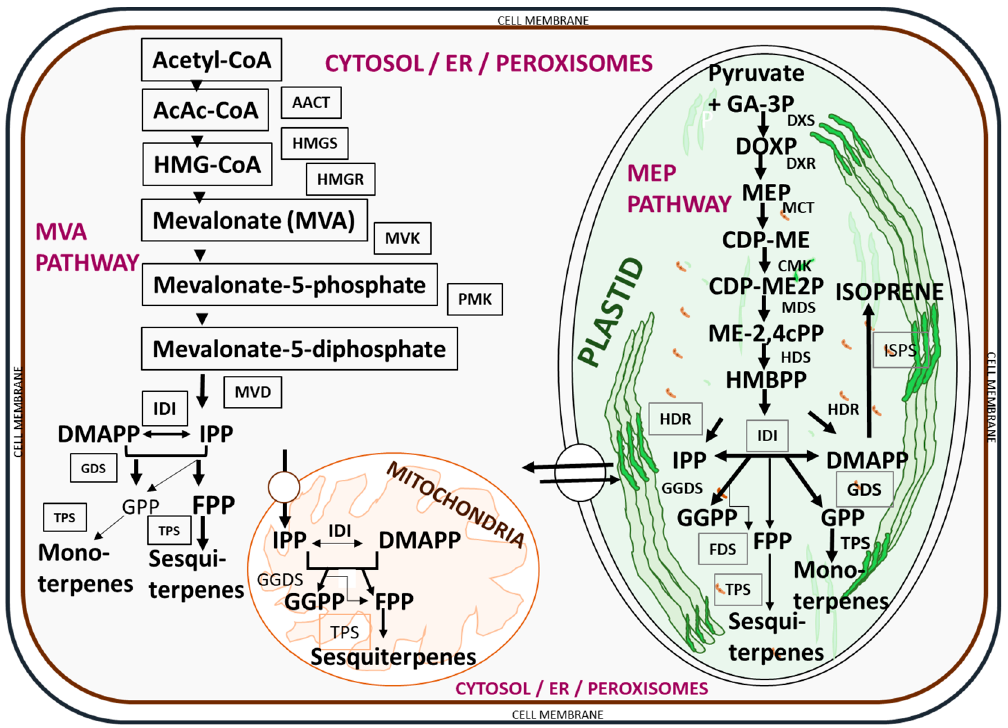
Figure 2. Biosynthetic pathways for essential oil compounds in plants. A list of enzymes involved in the biosynthesis includes acetoacetyl-CoA (AcAc-CoA), acetoacetyl-CoA thiolase (AACT), CDP- ME kinase (CMK), DOXP reducto-isomerase (DXR), DOXP synthase (DXS), farnesyl diphosphate synthase (FDS), geranyl diphosphate synthase (GDS), geranyl geranyl diphosphate synthase (GGDS), (E)-4-hydroxy-3-methylbut-2-enyl diphosphate reductase (HDR), (E)-4-hydroxy-3-methylbut-2-enyl diphosphate synthase (HDS), 3-hydroxy-3-methylglutaryl-CoA (HMG-CoA), HMG-CoA reductase (HMGR), HMG-CoA synthase (HMGS), isopentenyl diphosphate isomerase (IDI), isoprene synthase (ISPS), 2-C-methyl-D-erythritol-4-phosphate cytidylyltransferase (MCT), 2-C-methyl-D-erythritol 2,4-cyclodiphosphate synthase (MDS), mevalonate diphosphate decarboxylase (MVD), mevalonate kinase (MVK), phosphomevalonate kinase (PMK), and terpene synthase (TPS). The key intermediates (compounds) involved in the biosynthetic process include: 4-(cytidine 50-diphospho)-2-C-methyl-D-erythritol (CDP-ME), 4-(cytidine 50-diphospho)-2-C-methyl-D-erythritol phosphate (CDP-ME2P), isopentenyl diphosphate (IPP), dimethylallyl diphosphate (DMAPP), farnesyl diphosphate (FPP), geranyl geranyl diphosphate (GGPP), geranyl diphosphate (GPP), glyceraldehyde-3-phosphate (GA-3P), 2-C-methyl-D-erythritol 2,4-cyclodiphosphate (ME-2,4Cpp), 2-C-methyl-D-erythritol-4-phosphate (MEP), (E)-4-hydroxy-3-methylbut-2-enyl diphosphate (HMBPP), and 1-deoxy-D-xylulose 5-phosphate (DOXP). The pathways were adapted from Nagegowda [76] and redrawn with copyright permission by the Federation of European Biochemical Societies © 2010 Elsevier B.V. Publication.